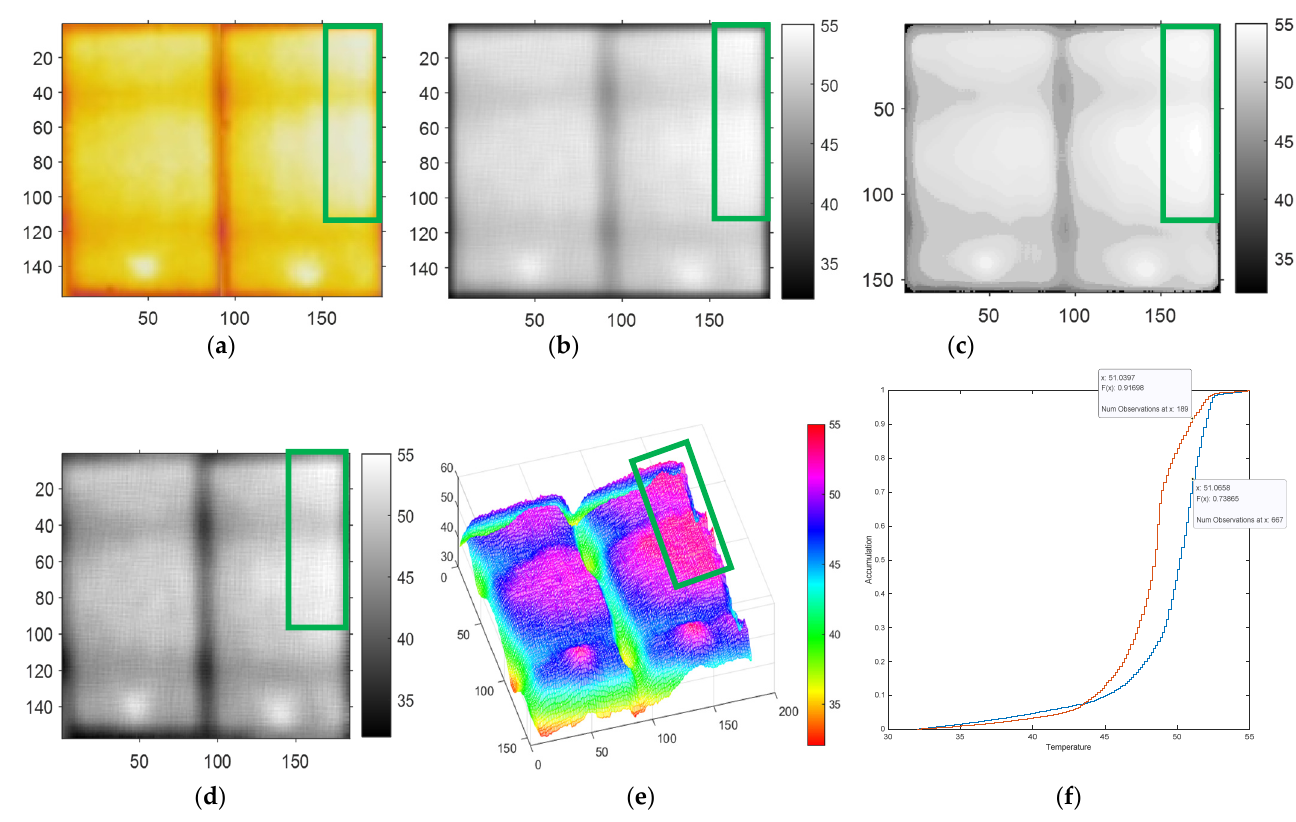
Figure 9. Comparison of different filtering methods with irradiance at 850 W/m 2 : ( a ) Original IR image. ( b ) Mean filter after grayscale treatment. ( c ) Median filter after grayscale treatment. ( d ) Im- proved box filter after grayscale treatment. ( e ) Improved box filter after 3D image. ( f ) Cumulative chart comparison of normal operation and abnormal conditions of solar